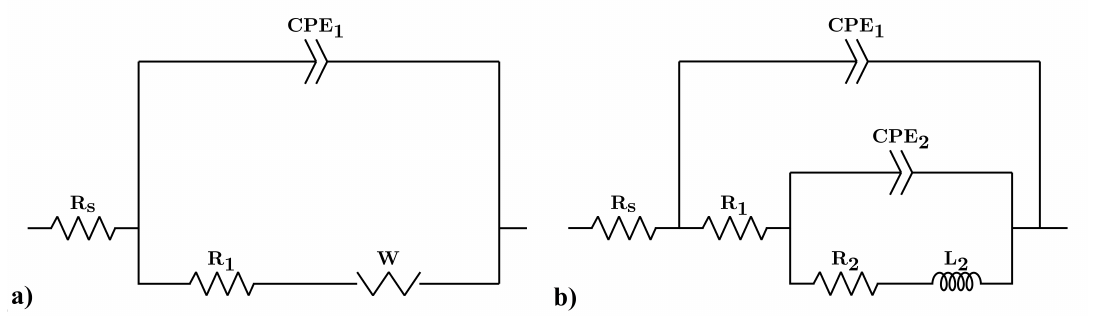
Figure 12. Equivalent circuit model of the interface between nitrided state and electrolyte: ( a ) for immersion times up to 6 h and ( b ) for 12, 18 and 24